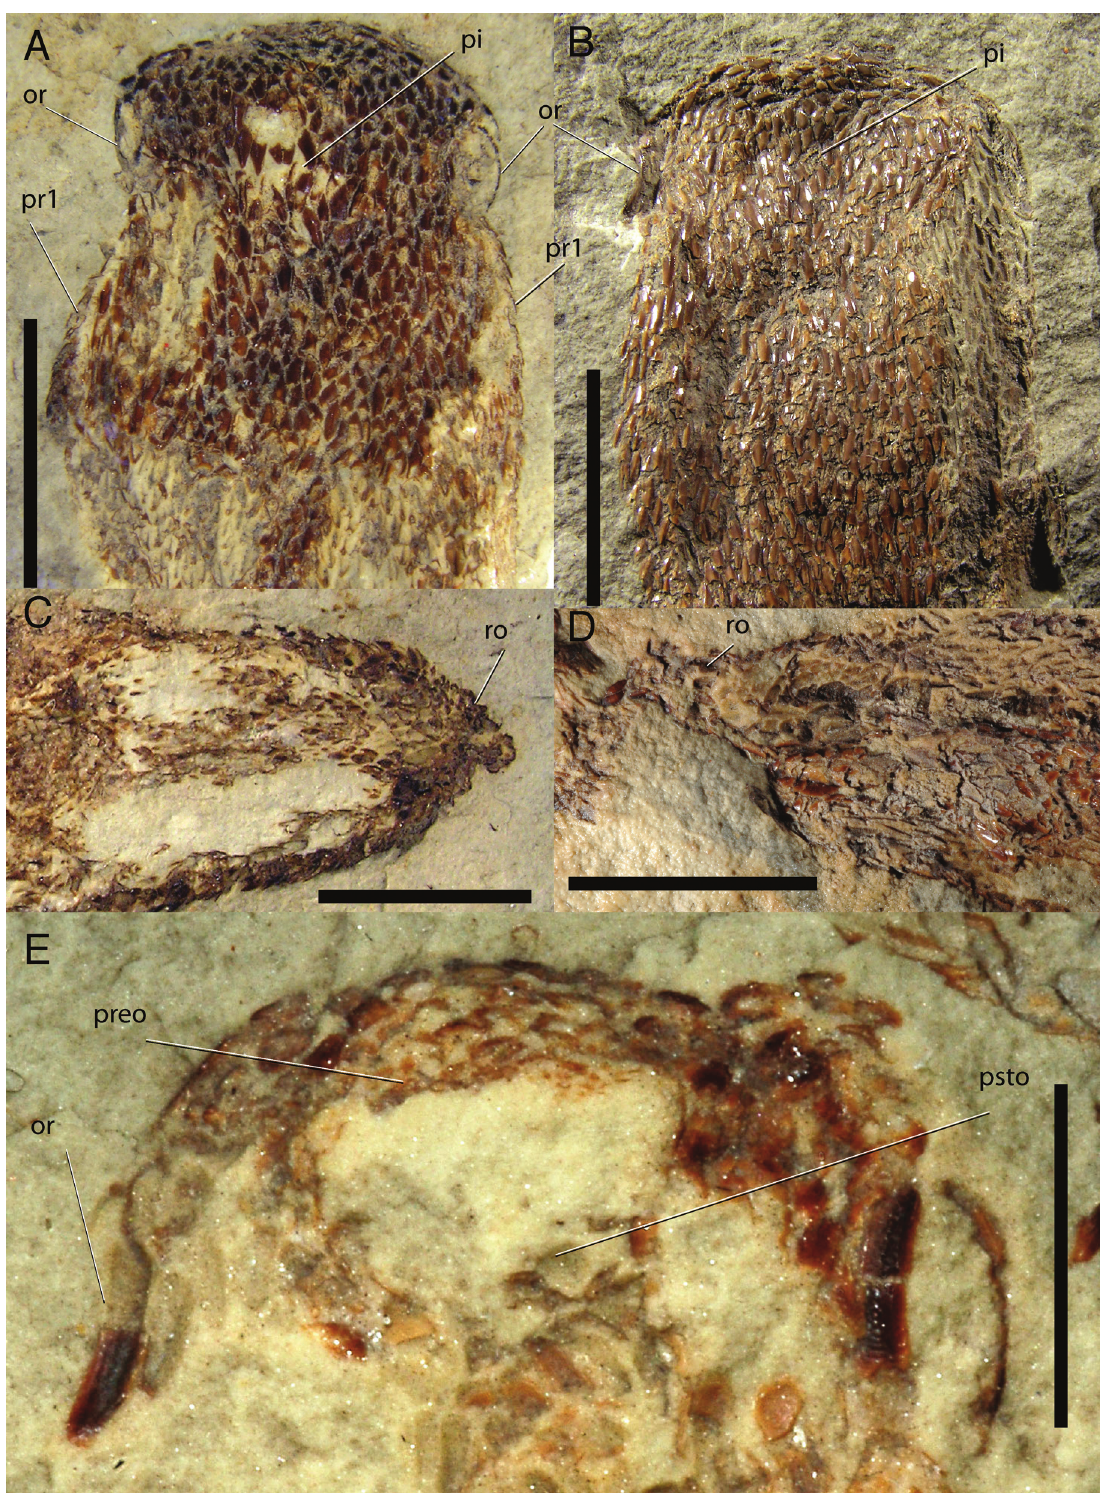
Fig. 4. Phlebolepis elegans Pander. Closeup images of the head, from Himmiste-Kuigu, Saaremaa, Estonia. A , TUG 865-9-2, part (previously numbered as Pi 6677); B , TUG 865-14-1; C , TUG 865-4-1; D , TUG 865-7-2; E , TUG 865-3-3. Scale bars for AD, 1 cm; for E, 5 mm. A, CE imaged wet. Abbreviations: or, orbital scales; pi, scales covering pineal organ; pr1, first (outer, leading edge) pectoral ray; preo, pre-oral scales; psto, post-oral scales; ro,